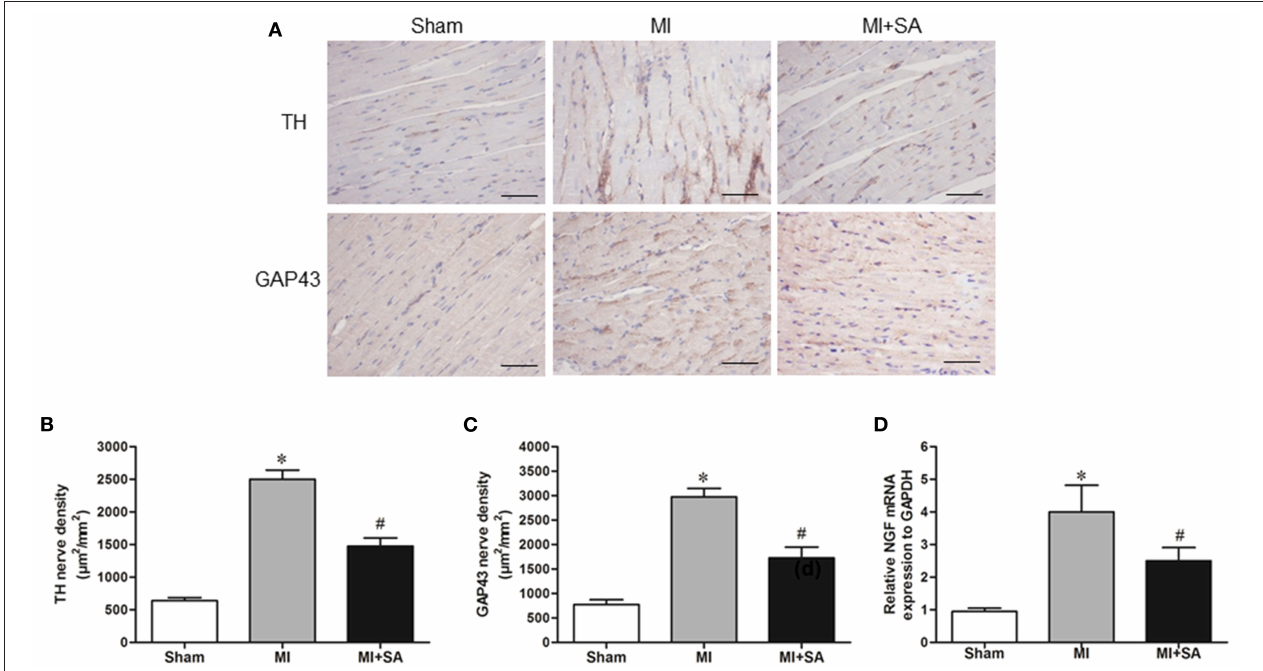
FIGURE 7 | SA attenuated sympathetic nerve remodeling and nerve sprouting at 4 weeks after MI. (A) TH and GAP43 were detected by immunohistochemistry. Scale bar, 50 µ m. (B,C) Quantitative analysis of TH and GAP43. (D) Expression of NGF mRNA in the three groups. *Compared with the sham group, P < 0.05, # Compared with the MI group, P < 0.05, n = 8 in each